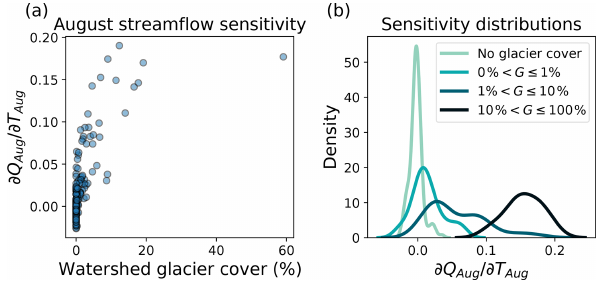
Figure 11. Modelled sensitivity of mean August streamflow to mean August temperature. (a) ∂Q Aug /∂T Aug increases nonlinearly with watershed glacier cover, G , indicating that greater water- shed glacier coverage is related to more positive ∂Q Aug /∂T Aug . (b) Probability distributions of ∂Q Aug /∂T Aug for different ranges of watershed glacier coverage, indicating that ∂Q Aug /∂T Aug for glacier-fed rivers is both greater than non-glacier-fed rivers and greater at increasing glacier coverage. All probability distributions are normalized to have unit